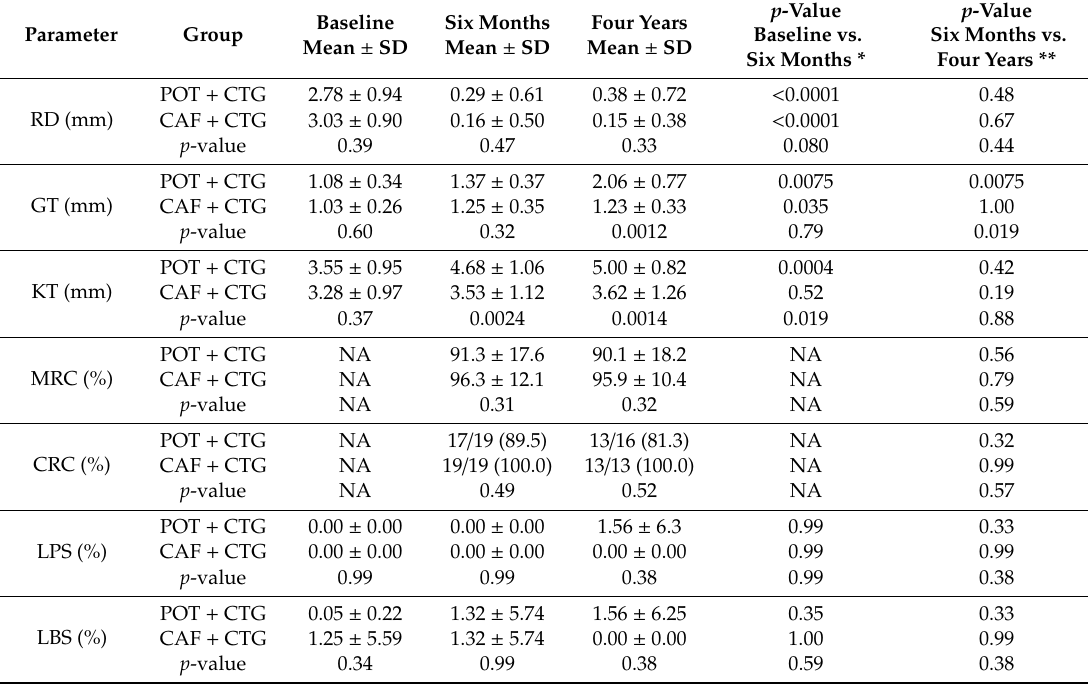
Table 2. Comparative evolution of periodontal parameters from baseline to four years in the treated (POT + CTG) and control (CAF + CTG)